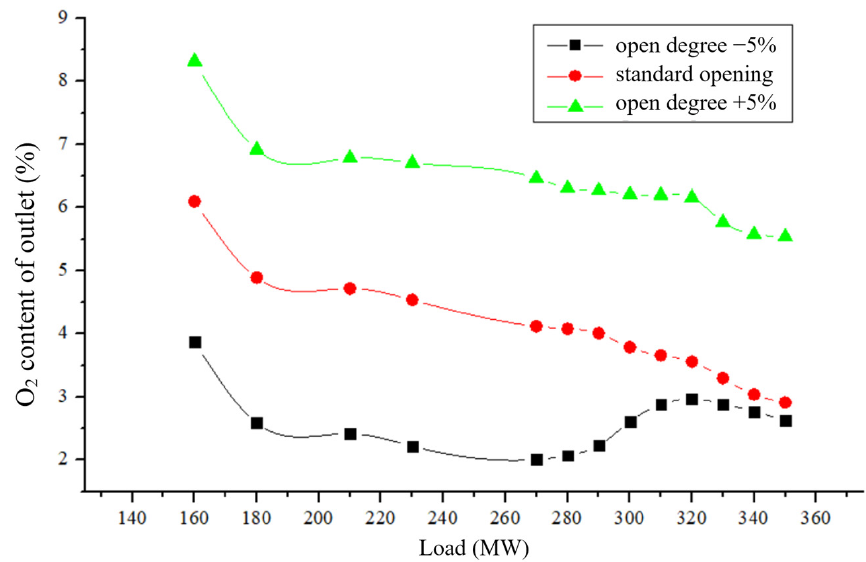
Figure 9. The oxygen content of outlet at variable combustion damper opening.